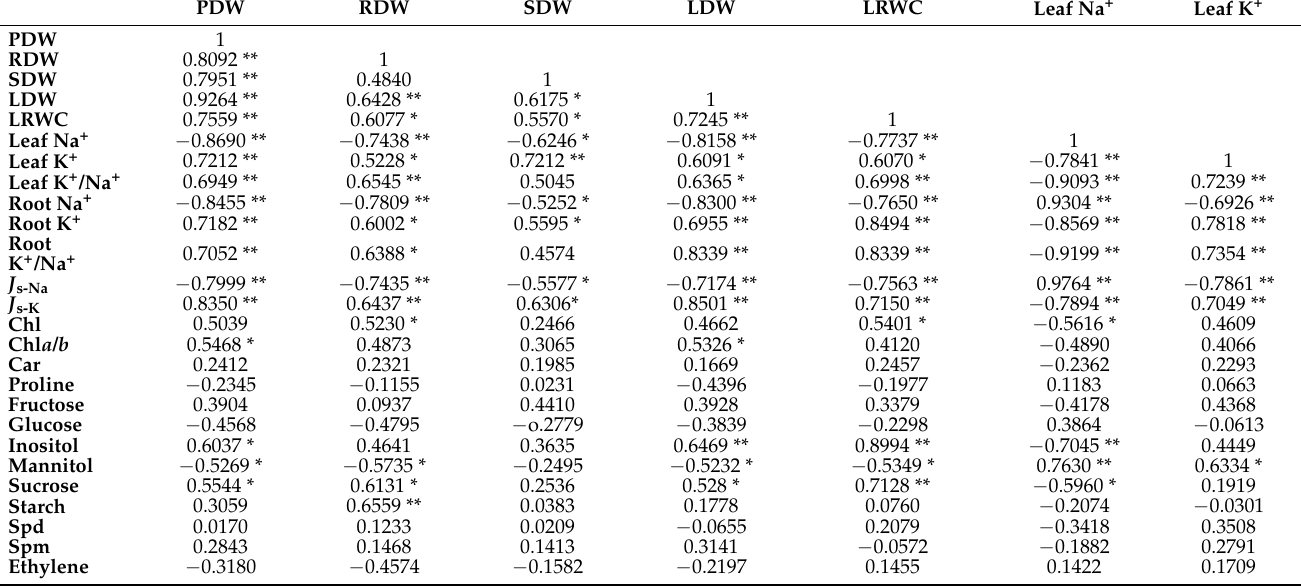
Table 6. Simple correlation coefficient (Pearson method) among all parameters studied in saline and non-saline conditions in Olea europea ( p ≤ 0.05 *; p ≤ 0.01 **). Abbreviations: PDW (plant dry weight); RDW (root dry weight); SDW (stem dry weight); LDW (leaf dry weight); LRWC (leaf relative water content); J s-Na (net translocation of Na + ); J s-K (net translocation of K + ); Chl (chlorophyll a + b ); Chl a / b